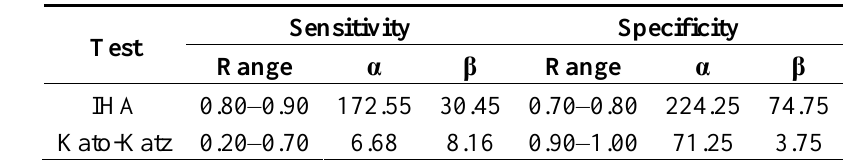
Table 3. Parameters of the beta(α, β) prior distributions for the sensitivities and specificities of IHA and Kato-Katz tests for S. japonica examination in the lake regions in Hubei,